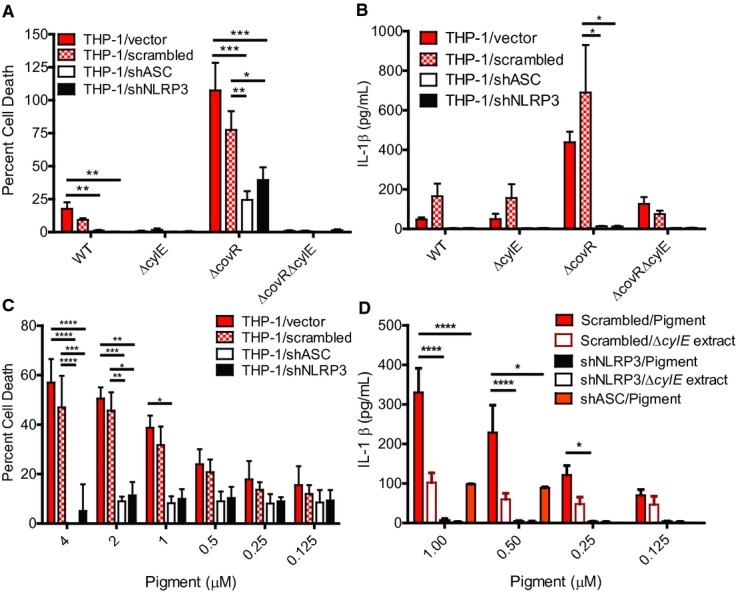
The GBS pigment induces NLRP3 inflammasome-dependent cell death in human macrophages
A, B THP-1 macrophages transfected with empty vector, scrambled control, shASC, or shNLRP3 were treated with GBS WT, ΔcylE, ΔcovR, or ΔcovRΔcylE at an MOI of 1 and incubated for 4 h. Cytotoxicity was measured by LDH release (A), and IL1β release in supernatants was measured by Luminex assay (B). Data from three independent experiments performed in triplicate are shown.

C, D The shRNA THP-1 macrophages were incubated with various concentrations of GBS pigment or ΔcylE extract for 4 h. Cytotoxicity was measured by alamar blue assay (C), and IL1β release in supernatants was measured by Luminex assay (D). Pigment-mediated cytotoxicity is dependent on the NLRP3 inflammasome components, suggesting that pigment is inducing a programmed cell death. Data shown are the average of at least three independent experiments performed in triplicate.
Data information: Data were analyzed using Bonferroni's multiple comparison test following ANOVA, error bars ± SEM. (A) n = 3, for WT: **P = 0.001 (vector versus shNLRP3), **P = 0.0016 (vector versus shASC); for ΔcovR: ***P = 0.0008 (vector versus shNLRP3), ***P = 0.0001 (vector versus shASC), *P = 0.047 (scrambled versus shNLRP3), **P = 0.0054 (scrambled versus shASC). Data obtained from THP-1/vector was not significantly different from THP-1/scrambled, P = 0.18. (B) n = 3, *P = 0.025. Data obtained from THP-1/vector were not significantly different from THP-1/scrambled, P = 0.89. (C) n = 3, for 4 μM pigment: **P = 0.0063 (vector versus shNLRP3), **P = 0.0035 (vector versus shASC), *P = 0.01 (scrambled versus shNLRP3), **P = 0.009 (scrambled versus shASC); for 2 μM pigment: **P = 0.0088 (vector versus shNLRP3), **P = 0.0066 (vector versus shASC), *P = 0.01 (scrambled versus shNLRP3 or shASC); for 1 μM pigment: *P = 0.02 (vector versus shNLRP3), *P = 0.01 (vector versus shASC). Data obtained from THP-1/vector were not significantly different from THP-1/scrambled, P = 0.99. (D) n = 3, ****P < 0.0001, *P = 0.015.